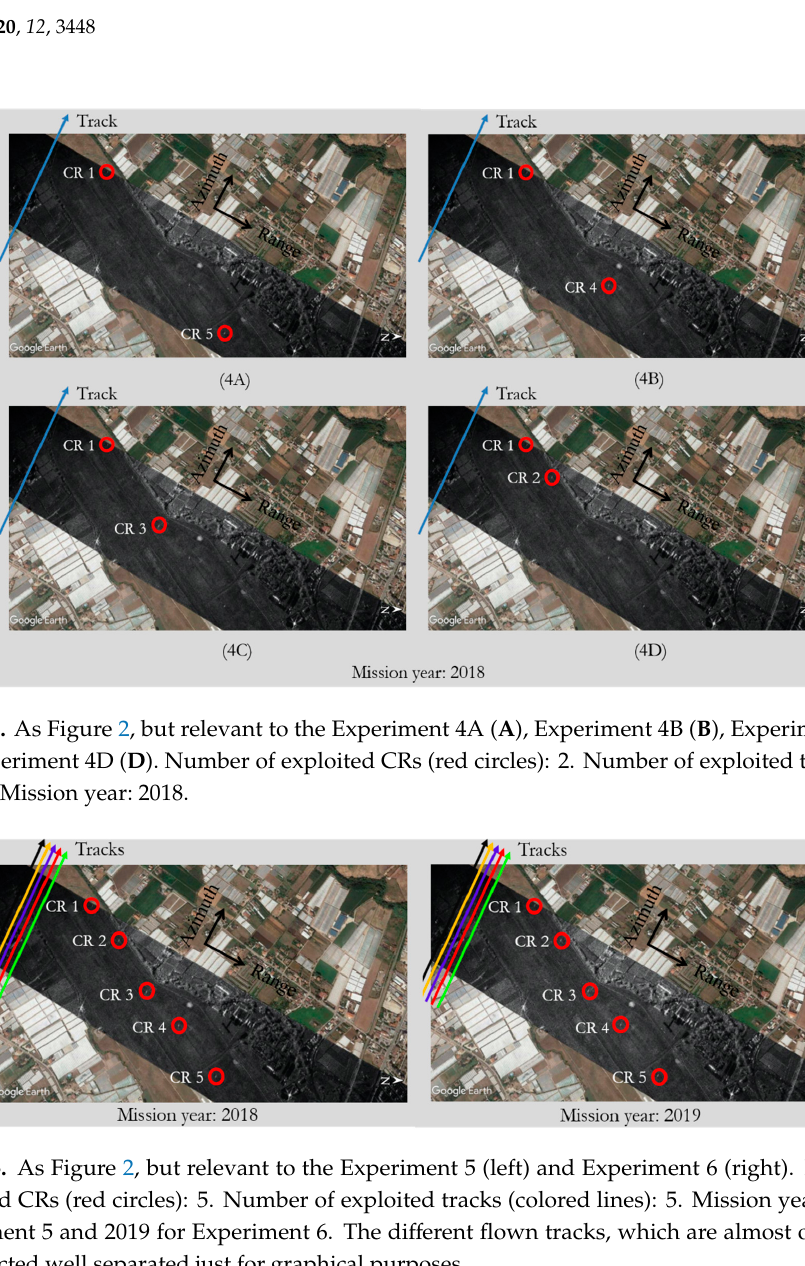
Figure 6. As Figure 2, but relevant to the Experiment 7. Number of exploited CRs (colored circles): 5. Number of exploited tracks (colored lines): 5. Mission year: 2018. Only one CR per track is used,